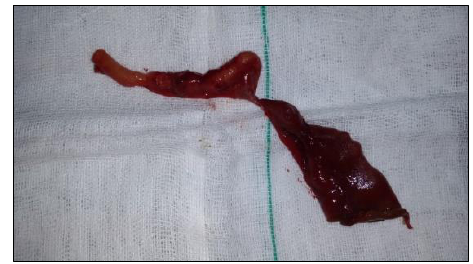
Figure 2. Atretic portion of the jejunum after